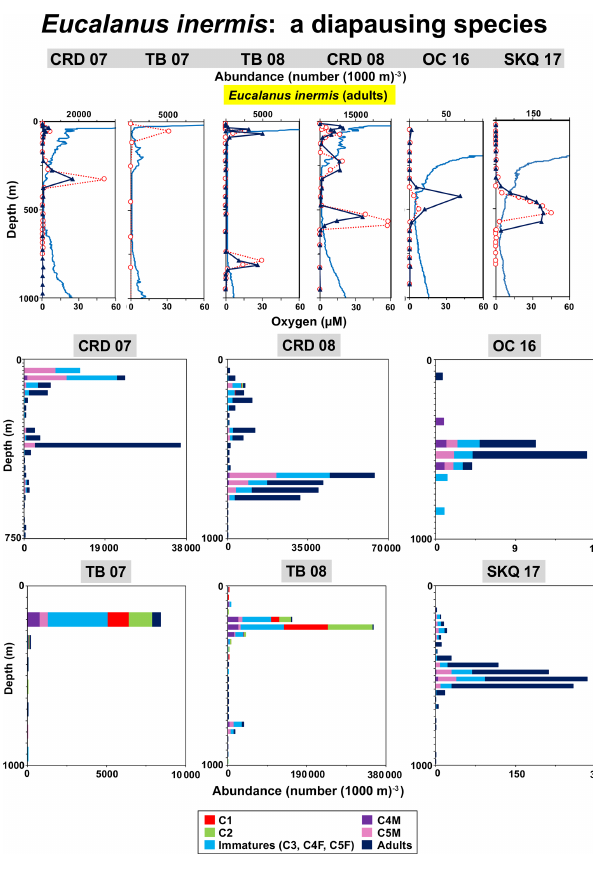
Figure 8. Vertical distributions relative to oxygen for Eucalanus inermis adults day and night at each station (top row), and daytime life history stage distributions (color-coded bar graphs) at each of these stations (two bottom rows). Abundance axes vary. Bars are plotted by sample order with increasing depth. At CRD in 2007, daytime data extended only to 750m. See the vertical profiles (top row) and Tables 1 and S1 (Wishner et al., 2019) for depth ranges for each net and Table 3 for the DMA. See Fig. 3 caption for more explanation of the vertical profiles.